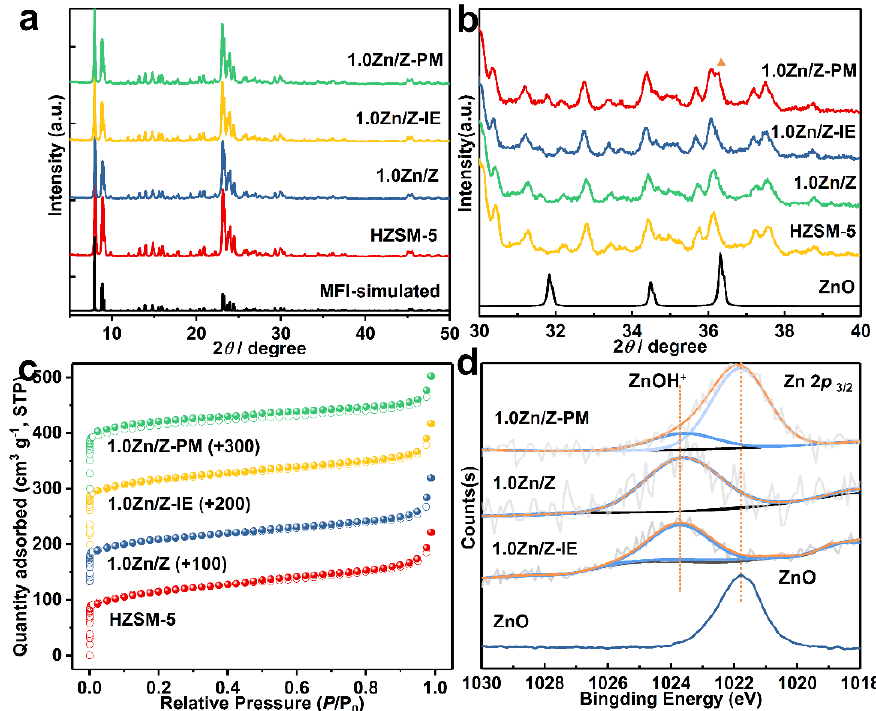
Figure 4. XRD patterns in range of 5–50 ◦ of ZSM-5 samples and MFI simulated one ( a ), and in range of 30–40 ◦ of ZSM-5 samples and ZnO ( b ); N 2 adsorption-desorption isotherms at 77 K of HZSM-5 and ZSM-5 samples by different Zn-loading strategies ( c ); fittings of Zn 2 p 3/2 peaks in XPS spectra of ZnO and ZSM-5 samples by different Zn-loading strategies ( d ). Table 3. Zn content, texture properties, acidities and ratios of Zn species of 1.0Zn/Z, 1.0Zn/Z-IE and 1.0Zn/Z-PM. Zn Content Catalyst